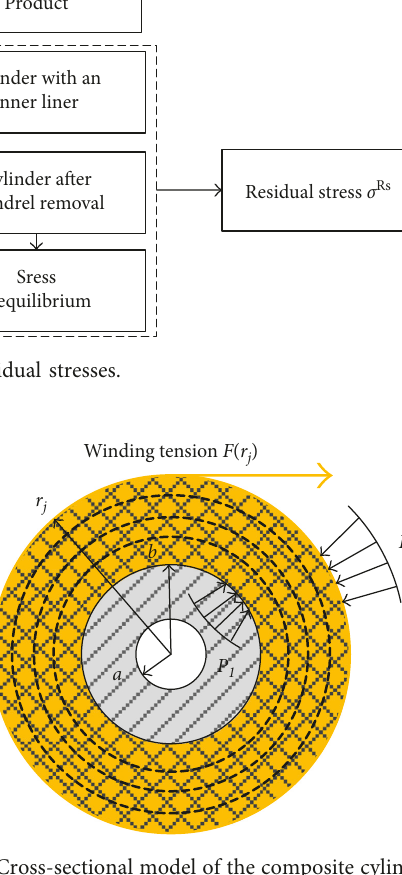
Figure 3: Cross-sectional model of the composite cylinder during the winding